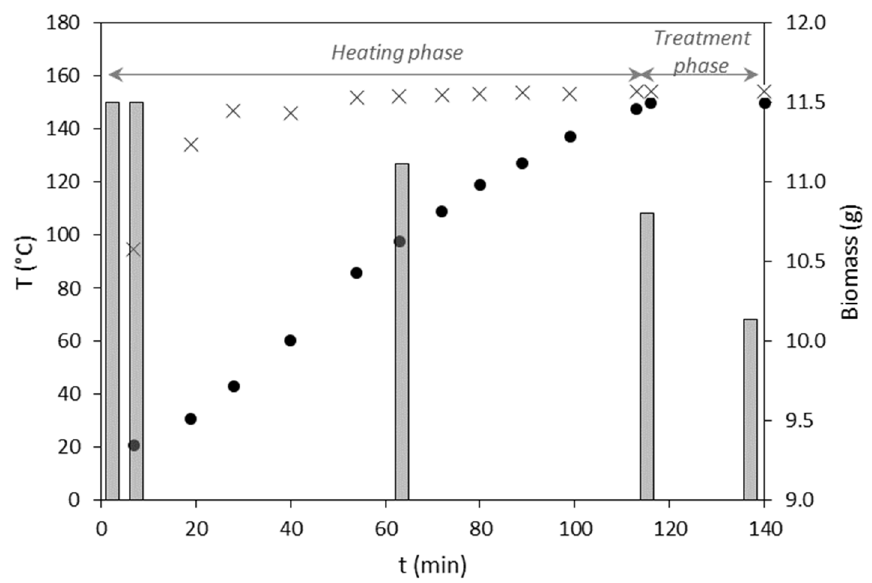
Figure 2. Heating profile of the SBW system (temperature of the water entering ( × ) and exiting ( • ) the reactor) and mass of the sample (bars) in the reactor during the assay performed at 150 °C.